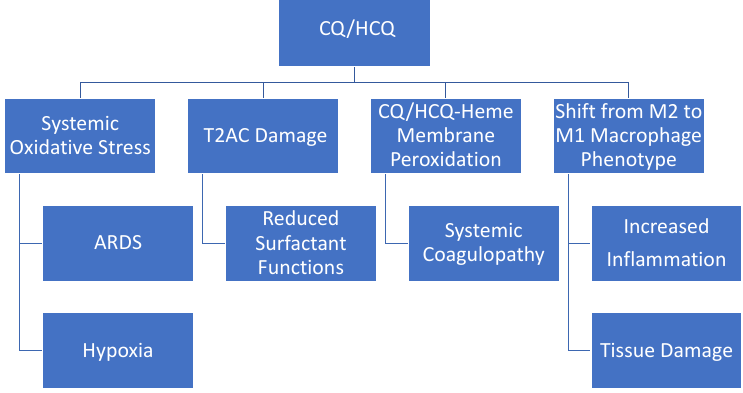
Figure 5. Potential adverse e ff ects of CQ / HCQ on COVID-19 patients. CQ / HCQ-induced systemic oxidative stress could contribute to the pathology of acute respiratory distress syndrome (ARDS) and hypoxia. Hypoxia, in turn, can contribute to increased production of reactive oxygen species (ROS) from mitochondria (see text). CQ / HCQ-induced damage to type II alveolar cells (T2ACs) and surfactant function could also contribute to ARDS and hypoxia / hypoxemia. As indicated in Figure 4, CQ can form a complex with free-heme that promotes biomembrane lipid peroxidation and this process could contribute to the systemic coagulopathy found in severe COVID-19 (see text). CQ / HCQ could also alter the immune responsive by promoting a shift in macrophage phenotype from M2 to M1 (see text). The M1 macrophage phenotype is proinflammatory and promotes tissue damage. The potential adverse e ff ects of CQ / HCQ summarized in this figure need to be further confirmed by additional in vivo and in vitro studies.